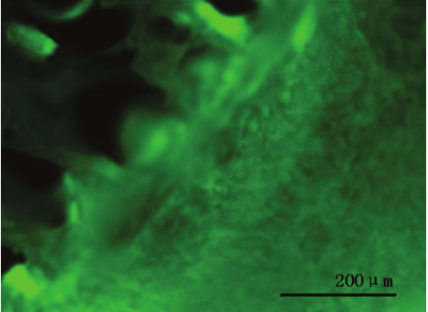
Figure 5: Confocal laser scanning microscopy of cell-scaffold complexes at 72 h after seeding. Complexes were incubated with fluorescent solution (2 mM ethidium Homodimer-1 and 4mM calcein AM). Green indicates living cells. Bar = 200